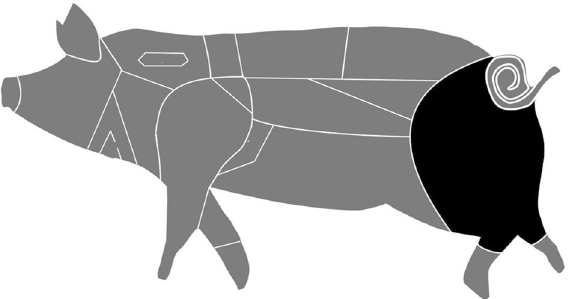
Figure 2. Pork cutting and processing areas and the area selected for the sampling of the reference collection